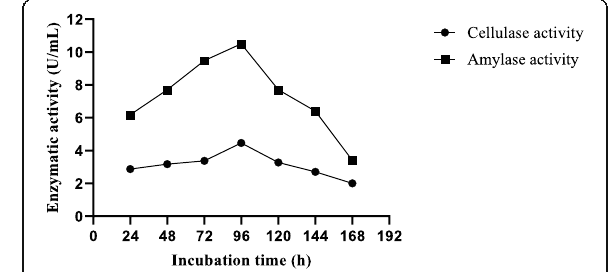
Fig. 4 Effect of incubation time on production of amylase and cellulase enzymes A. niger